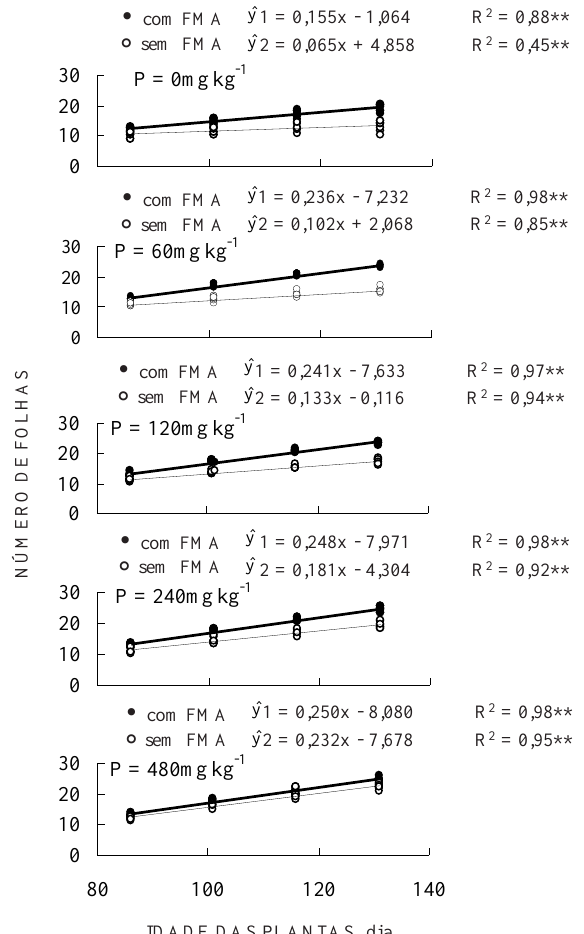
IDADE DAS PLANTAS, dia Figura 3. Número médio de folhas de plantas de mamoeiro, para cada dose de fósforo adicionada ao substrato, com e sem inoculação com Glomus macrocarpum , considerando a idade das plantas, fase de vaso. Média de quatro repetições.(** significativo a 1 %).